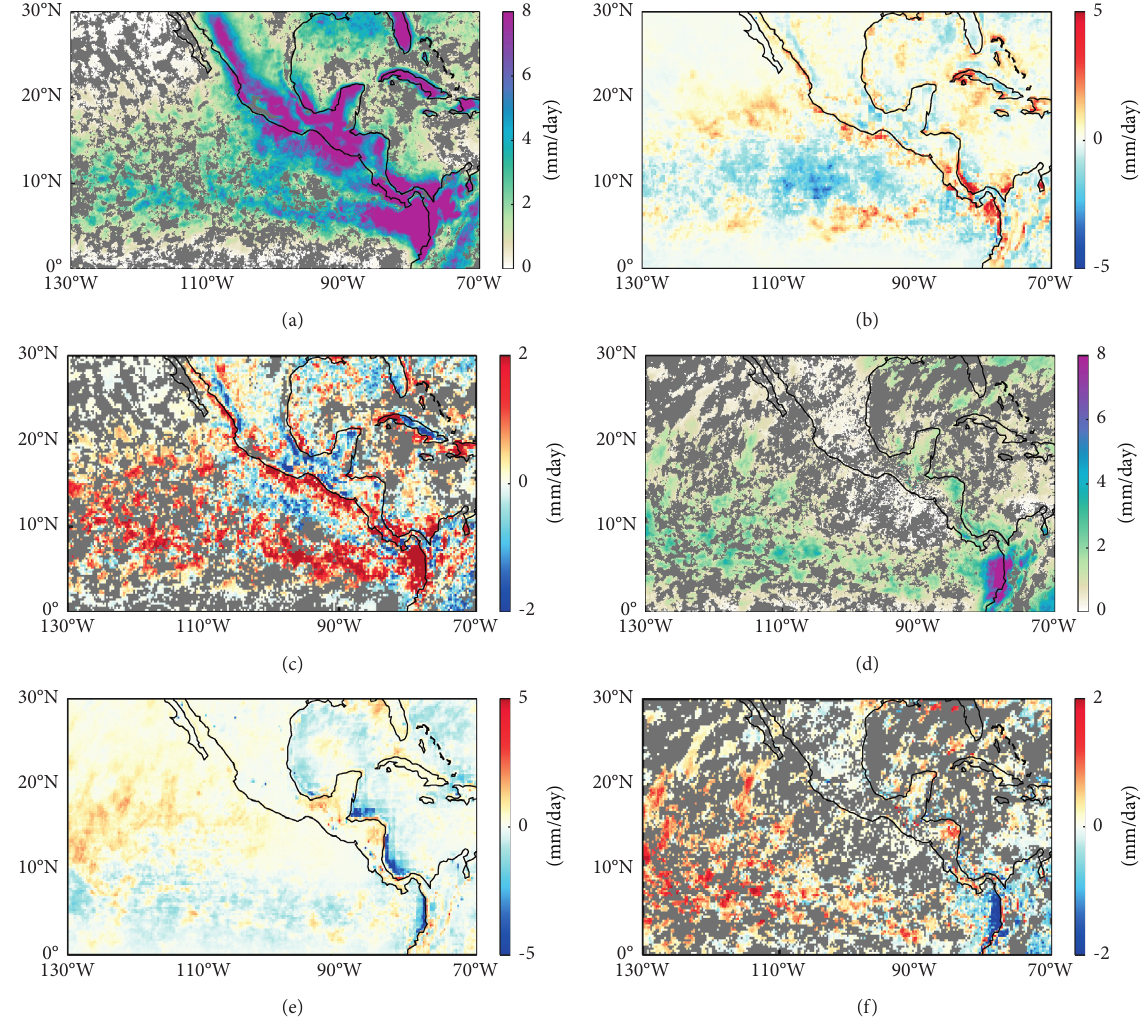
Figure 11: As Figure 10 but for the west coast of Central America. The grey areas indicate the diurnal harmonics were not statistically significant at the 90% confidence level. (a) Amplitude in IMERG (JJA). (b) Differences of mean precipitation (JJA). (c) Differences of amplitude (JJA). (d) Amplitude in IMERG (DJF). (e) Differences of mean precipitation (DJF). (f) Differences of amplitude